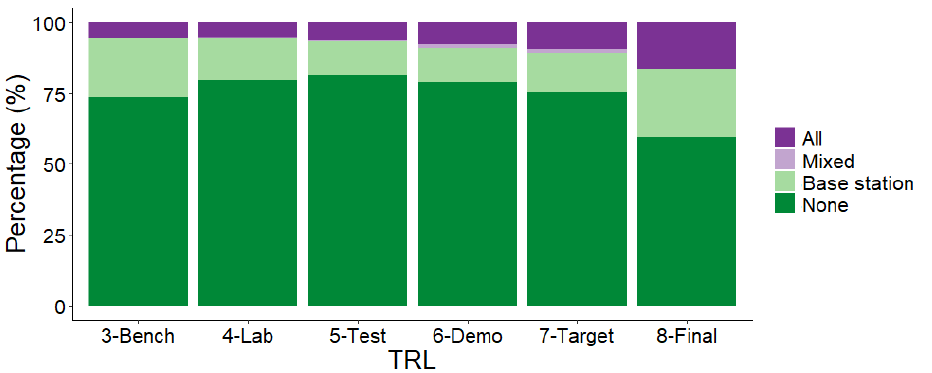
Figure 8. Deployment distribution between TRL and usage of rich nodes.